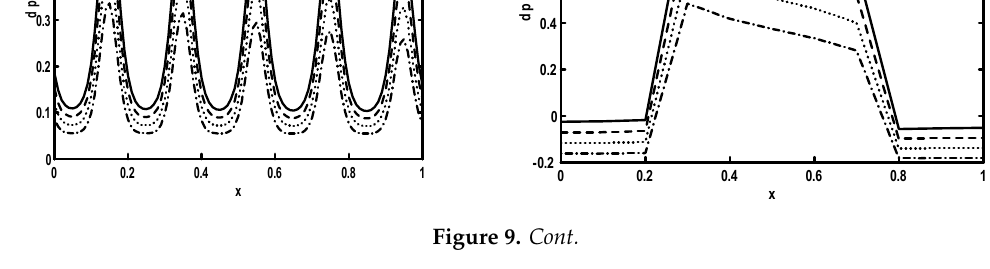
ff erent values of η and η for fixed a = 0.7, α = 0.2, b = 0.7, 1 2 Fig. 8 π = 0.3, k = 0.1, Q = 1. , M = 0.5, Re = 0.4, ϕ = , λ 3 4 1 Fig. 8